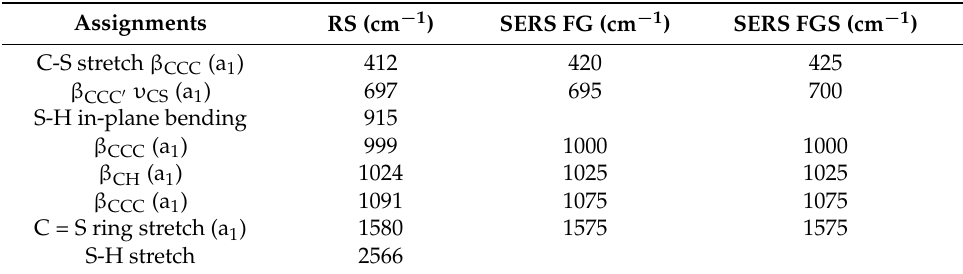
Figure 4. Optical images of ( a1 ) the FG and ( b1 ) the FGS microtubules used as substrates for surface enhanced Raman spectroscopy (SERS). The short lines on the images indicate the region analyzed. The SERS-corresponding spectra of thiophenol, obtained using a laser at 633 nm, are shown in ( a2 , b2 ). Vibrational assignments of characteristic vibrational frequencies are shown in Table 1. Table 1. Vibrational assignment of thiophenol [41,42] characteristic modes observed in inelastic Raman scattering (RS) and by SERS using two different